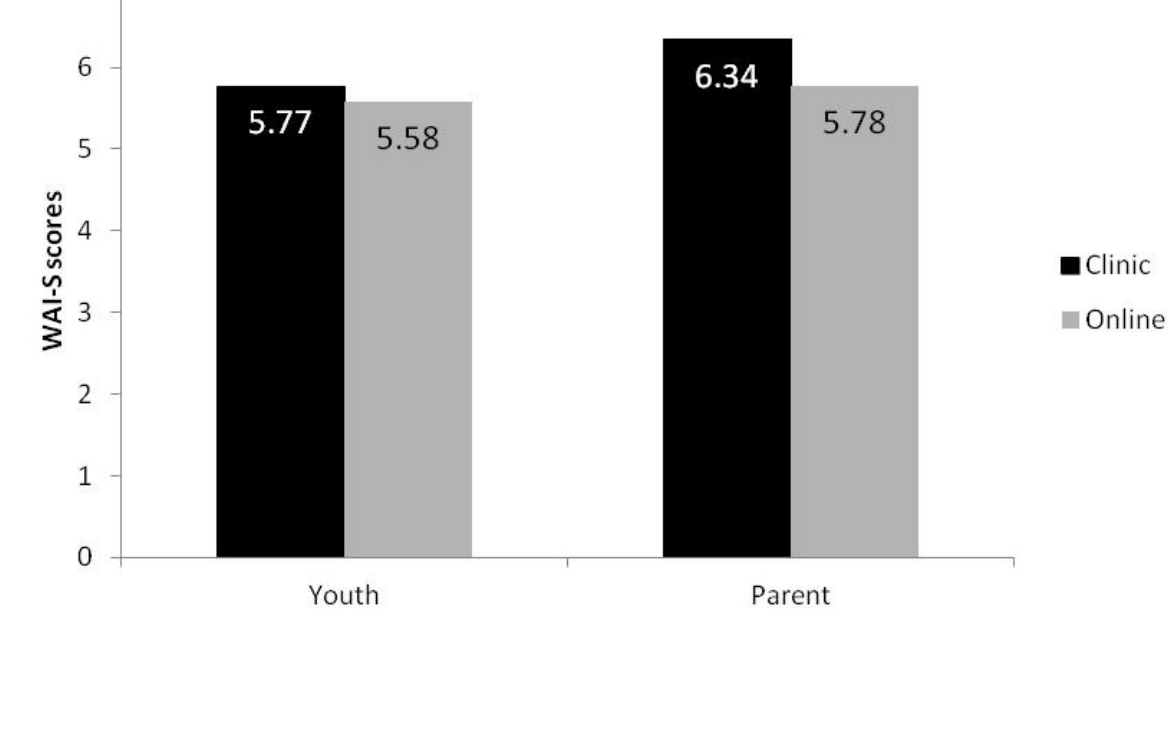
Figure 1. Mean Working Alliance Inventory-Short Form (WAI-S) scores for youths and parents in the face-to-face condition (clinic) and Internet condition